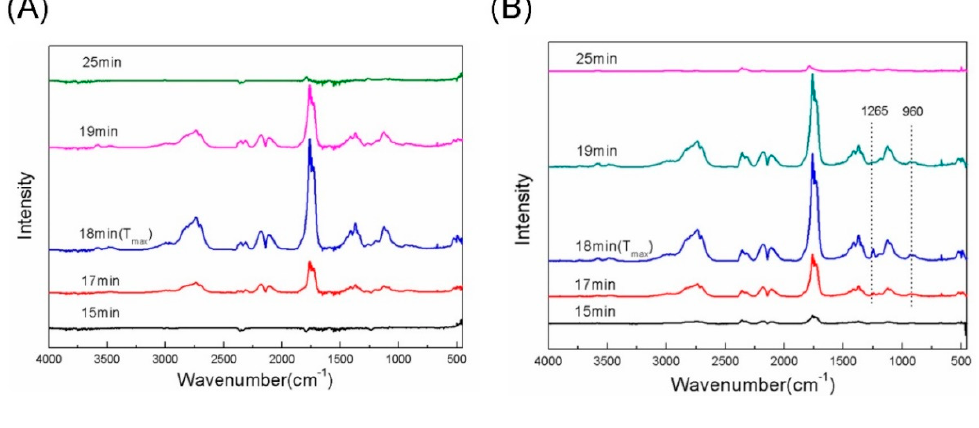
Polymers 2019 , 11 , x FOR PEER REVIEW 13 of 16 Figure 12. 3D images of evolved gas products for ( A ) neat-PLA and ( B ) P 5 PSQ-PLA.